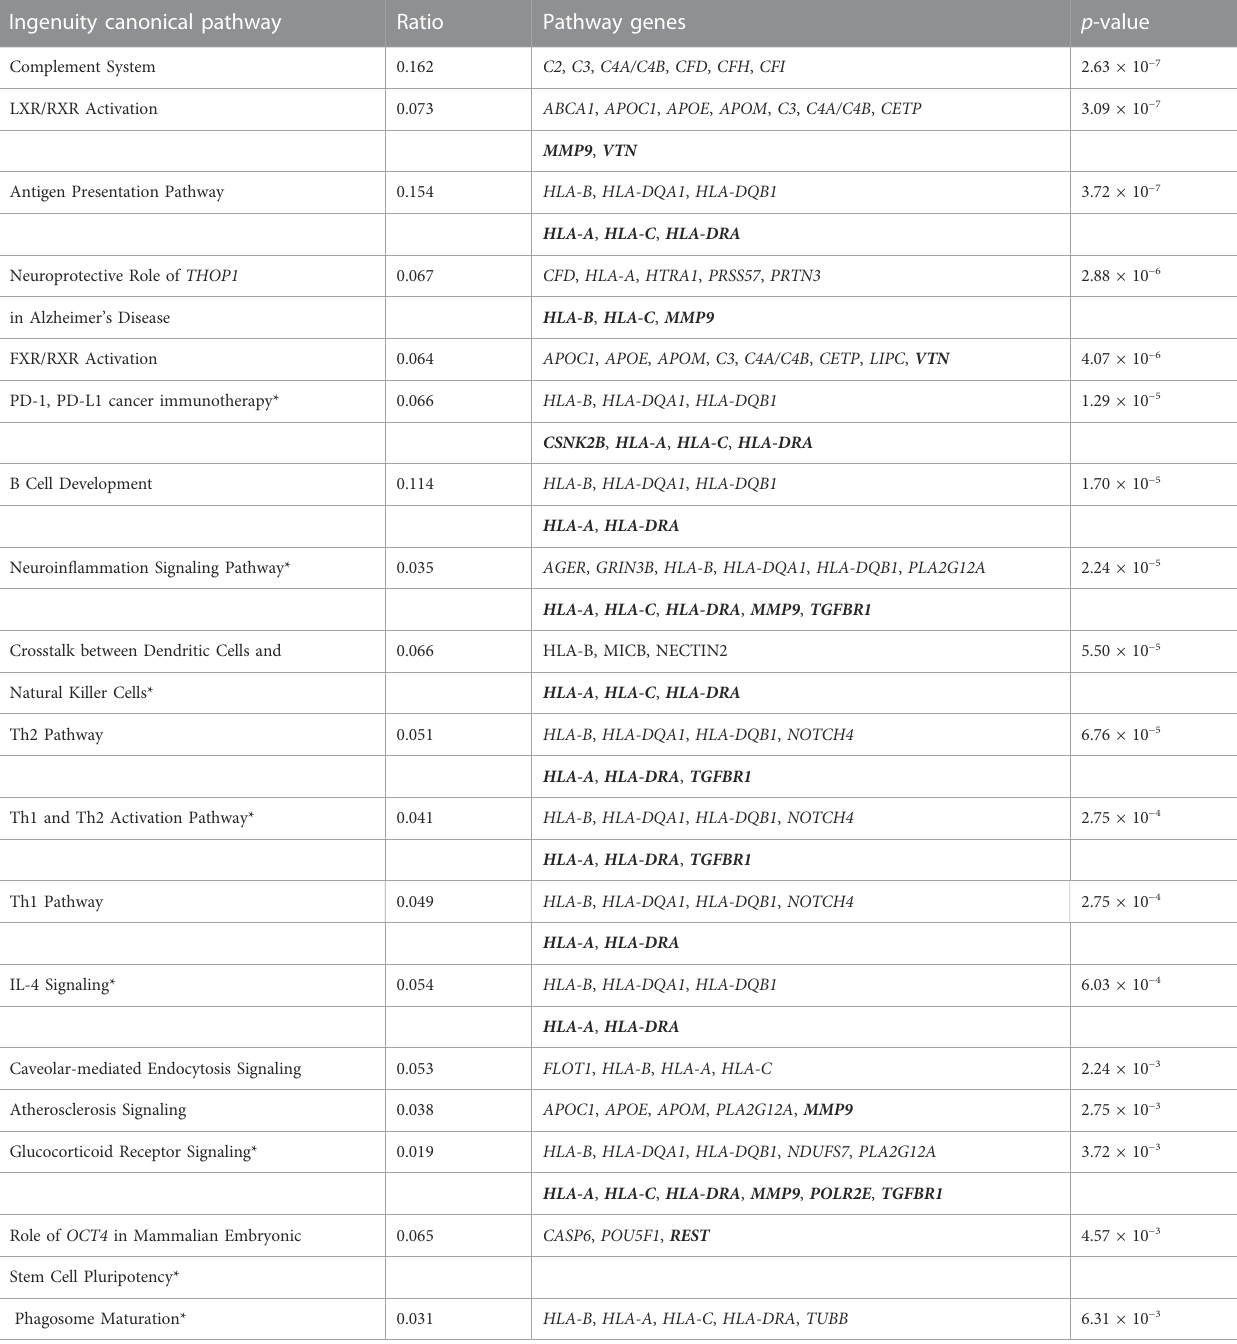
TABLE 3 Enriched canonical pathways from Ingenuity Pathway Analysis